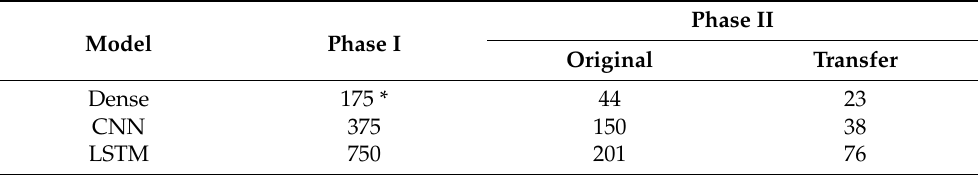
Table 5. The computational time for training neural networks in phase I and II of modeling. Phase II Model Phase I Original Transfer Dense 175 * 44 23 CNN 375 150 LSTM 750 201